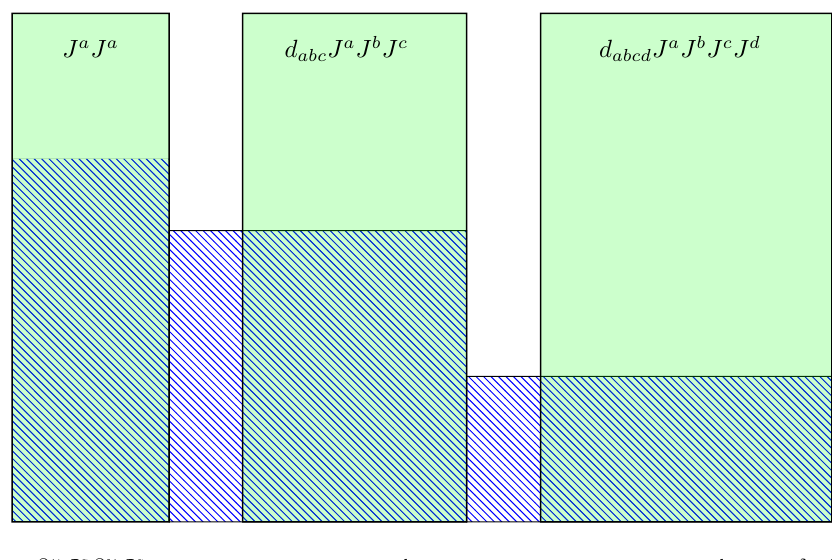
Figure 1 . The operators in the top-most row correspond to the SU( N ) Casimir invariants. A subset of generators for the stringy coset algebra is generated by acting by derivatives on the constituent terms of each Casimir operator. The cross-hatched area denotes the operators that are null and not part of the algebra for a given level k and N . For k = 1, only the top row of operators is not null and corresponds to the W N algebra. Increasing the level k reduces the cross-hatched area but does not eliminate it completely even as k tends to columns and also reducing the cross-hatched area. As we take N to null states disappear from the first column and the algebra becomes